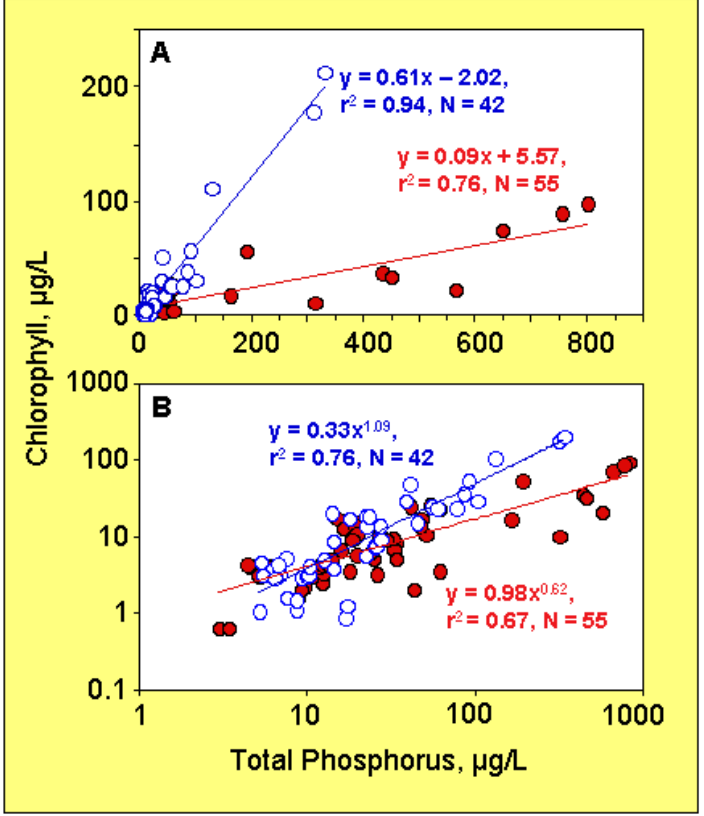
FIGURE 4. Chlorophyll–total phosphorus relationships in systems containing planktivorous fish with ( red, closed ) and without ( blue, open ) piscivorous fish. Each point represents a lake-summer from the nonconfounded experiments and surveys shown in Table 1. was dominated by small, highly vulnerable minnow species (fathead minnows[57]; sun bleak[54,75,76]). The three surveys consistent with the trophic cascade hypothesis included systems in which the planktivore assemblages were also dominated by small, highly vulnerable species (various atherinid spp.[124]; minnows[53, 127,128]). In addition to absolute reductions in planktivore abundance, piscivores may elicit behavioral responses in planktivores that result in reductions in planktivory even though fish densities are not reduced. For example, planktivores, responding to visual and/or chemical cues from piscivores[148], may leave the pelagic zone and seek refuge in the littoral zone[91,143,149,150,151,152,153,154]. Most studies examining the trophic cascade did not quantify habitat use by planktivores, so it is not possible to infer the importance of this indirect mechanism of reduction of pelagic planktivory in affecting the piscivore-mediated trophic cascades. Nevertheless, reduced densities of planktivorous fish in the pelagic zone, whether due to consumptive or behavioral mechanisms, results in lower predation pressure on pelagic